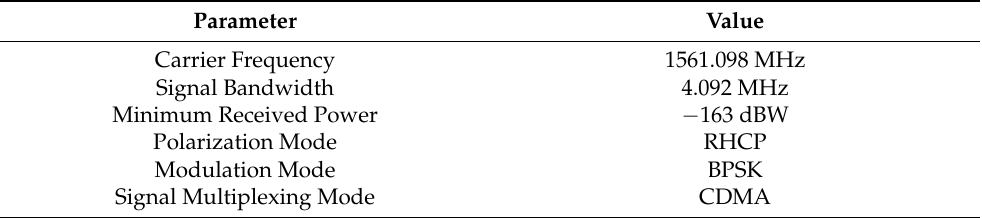
Table 1. Parameters of the B1I